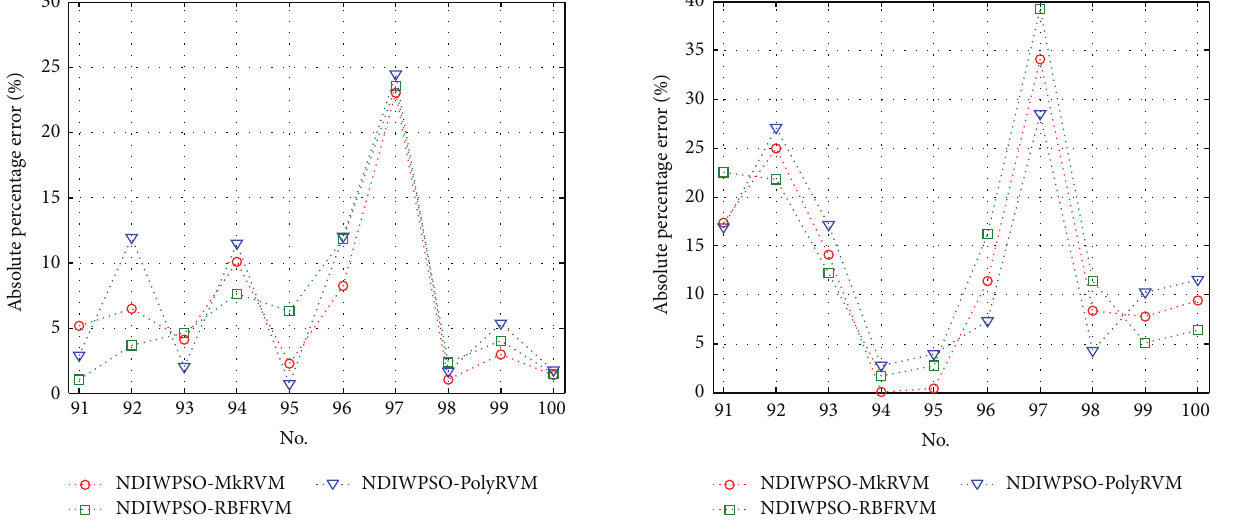
Figure 5: The comparison of the absolute percentage prediction errors for kurtosis of bearing vibration signal among NDIWPSO- MkRVM, NDIWPSO-RBFRVM and NDIWPSO-PolyRVM in case 2.